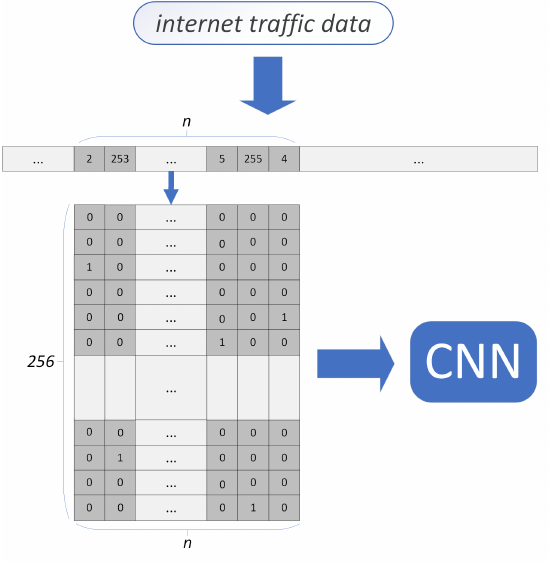
Figure 5. Introducing the second dimension using one-hot